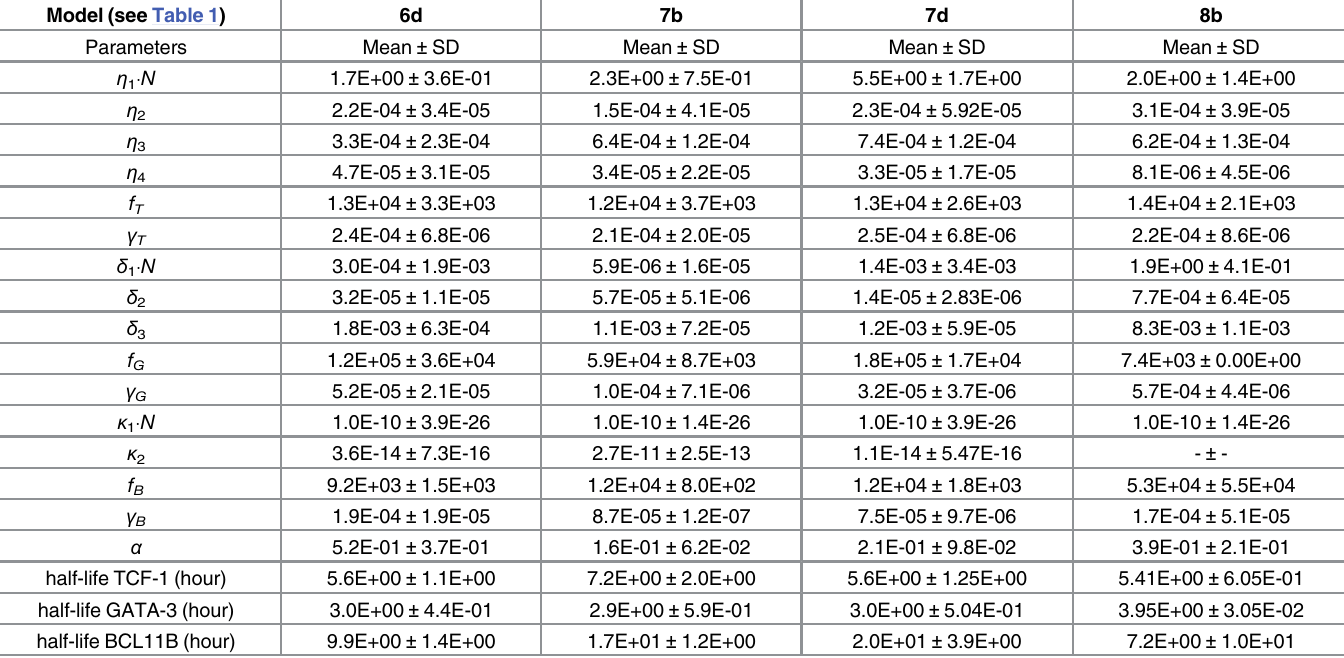
Table 2. Means and Standard Deviations (SD) for the winning parameters of the TCF-1, GATA-3, BCL11B, and Notch combinations with notation from Table 1: 6d = dimer TCF-1 AND (Notch OR dimer GATA-3); 7b = dimer GATA-3 AND (Notch OR TCF-1); 7d = dimer GATA-3 AND (Notch OR dimer TCF-1); 8b = Notch AND TCF-1 AND dimer GATA-3. The parameters are fully described in S1